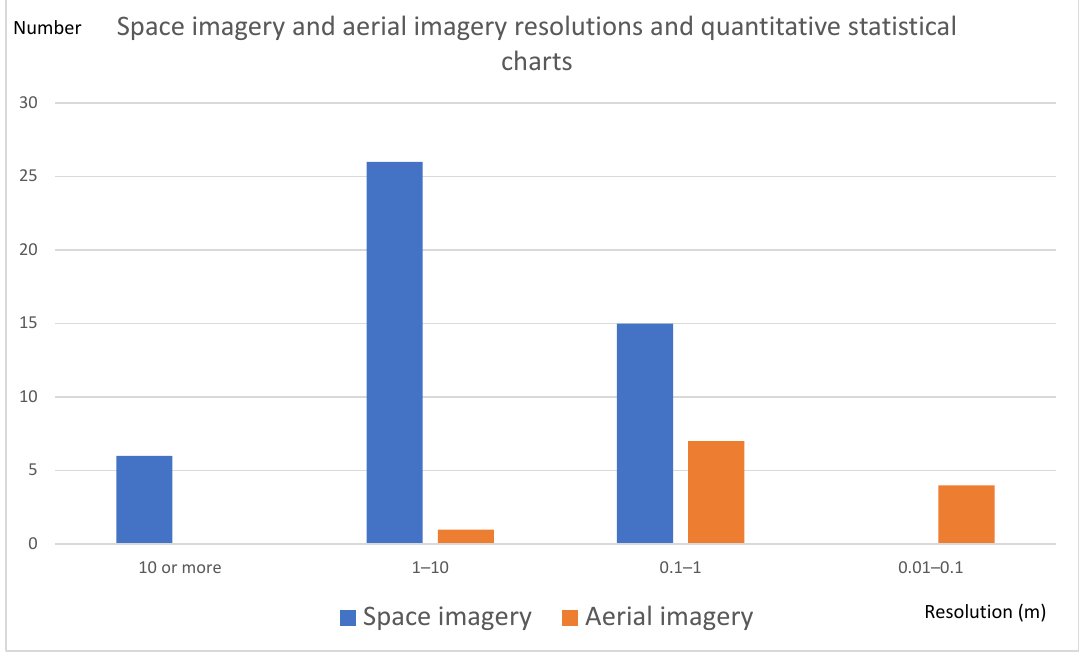
Figure 7. Space imagery and aerial imagery resolutions and quantitative statistical charts.